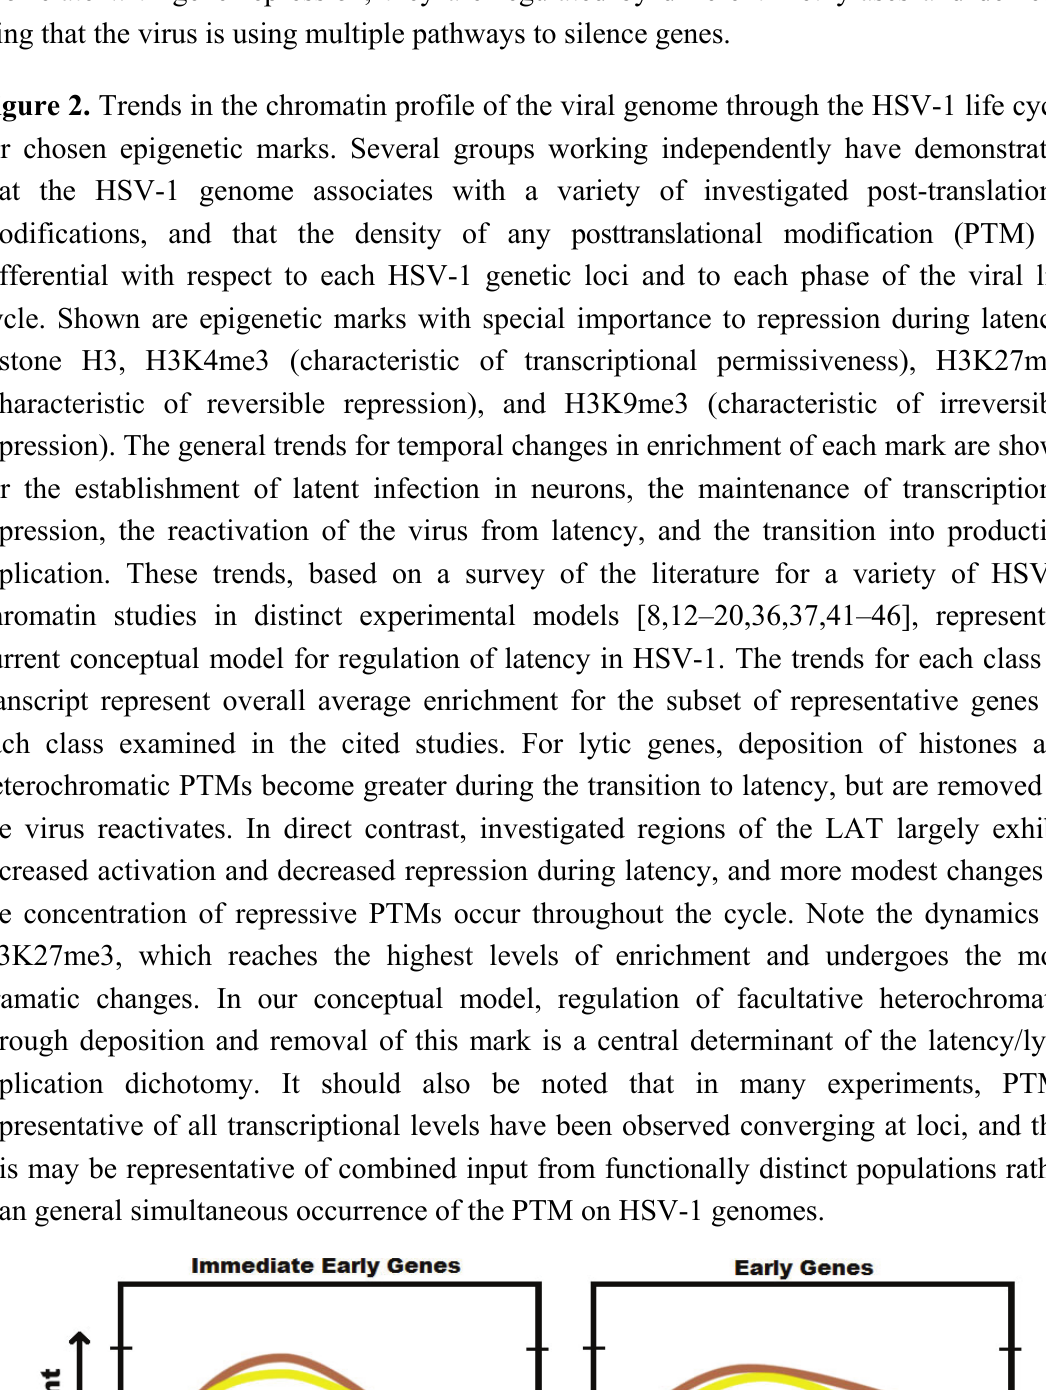
Figure 2. Trends in the chromatin profile of the viral genome through the HSV-1 life cycle for chosen epigenetic marks. Several groups working independently have demonstrated that the HSV-1 genome associates with a variety of investigated post-translational modifications, and that the density of any posttranslational modification (PTM) is differential with respect to each HSV-1 genetic loci and to each phase of the viral life cycle. Shown are epigenetic marks with special importance to repression during